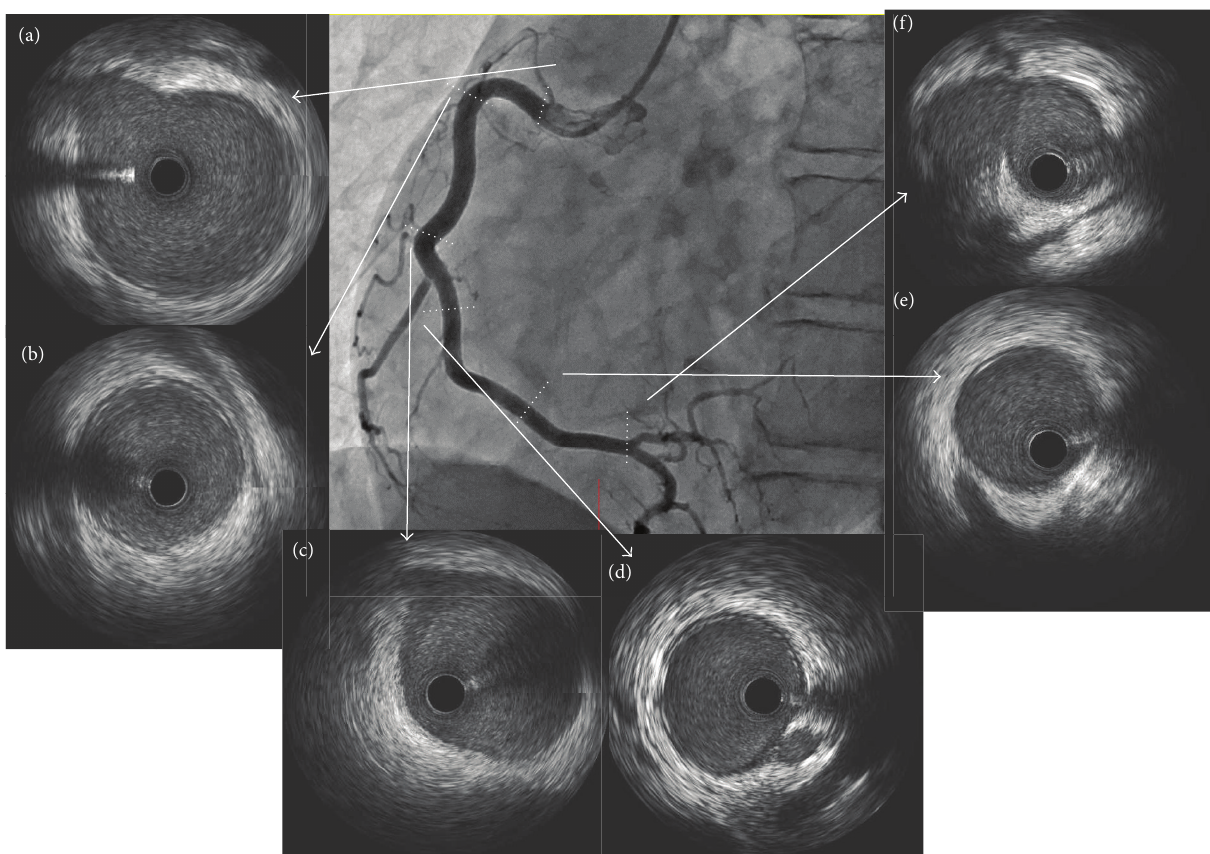
Figure 5: IVUS findings in the RCA 6 months after the onset of the MI. Spontaneous healing of the SCAD was observed in the whole RCA. CAG: LAO